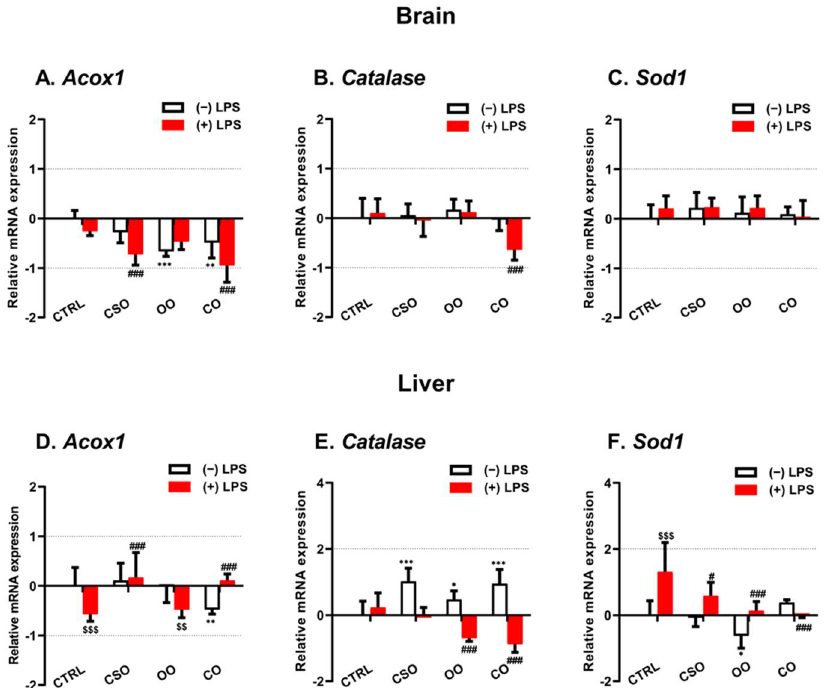
Figure 5. Effect of cactus seed oil, olive oil, or colza oil treatment on gene expression of Acox1 ( A , D ), Cat ( B , E ), and Sod1 ( C , F ) in brain and liver, respectively. Male C57BL/6 mice received for 28 days a standard diet (control (CTRL)), a diet enriched with 6% ( w / w ) CSO, OO, or CO, and intravenous injection of LPS (100 µg) four hours antemortem. First, total RNA was isolated from mice brains and livers, and then the expression level of genes of interest was quantified by real-time RT-qPCR. All values are means ± SD (n = 3), statistical significance of higher mean signal (*** p ≤ 0.001. ** p ≤ 0.01. * p ≤ 0.05) compared to control, (### p ≤ 0.01, # p ≤ 0.05) compared to LPS, and ($$$ p ≤ 0.001) com- pared to the different treatments with or without LPS administration. Statistics were executed using two-way ANOVA followed by Tukey test for multiple comparisons.